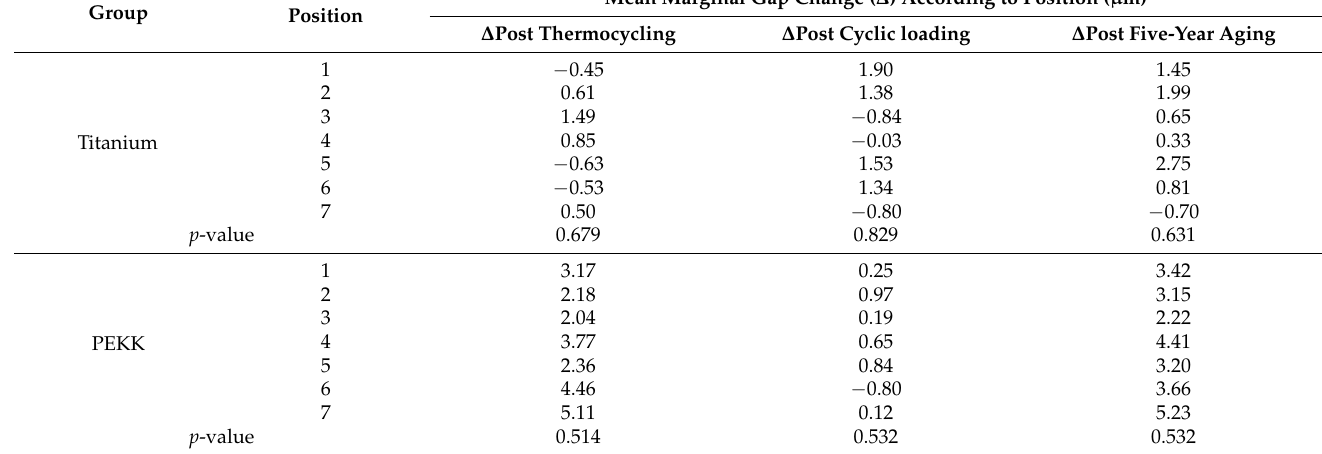
Table 3. Mean ( µ m) values of marginal gap change after different aging conditions according to positions.